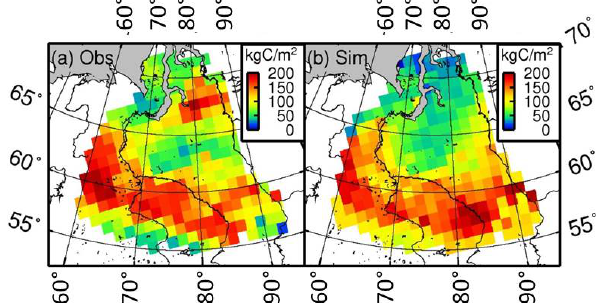
Fig. 6. Observed (from Sheng et al., 2004) and simulated soil carbon density, per unit wetland